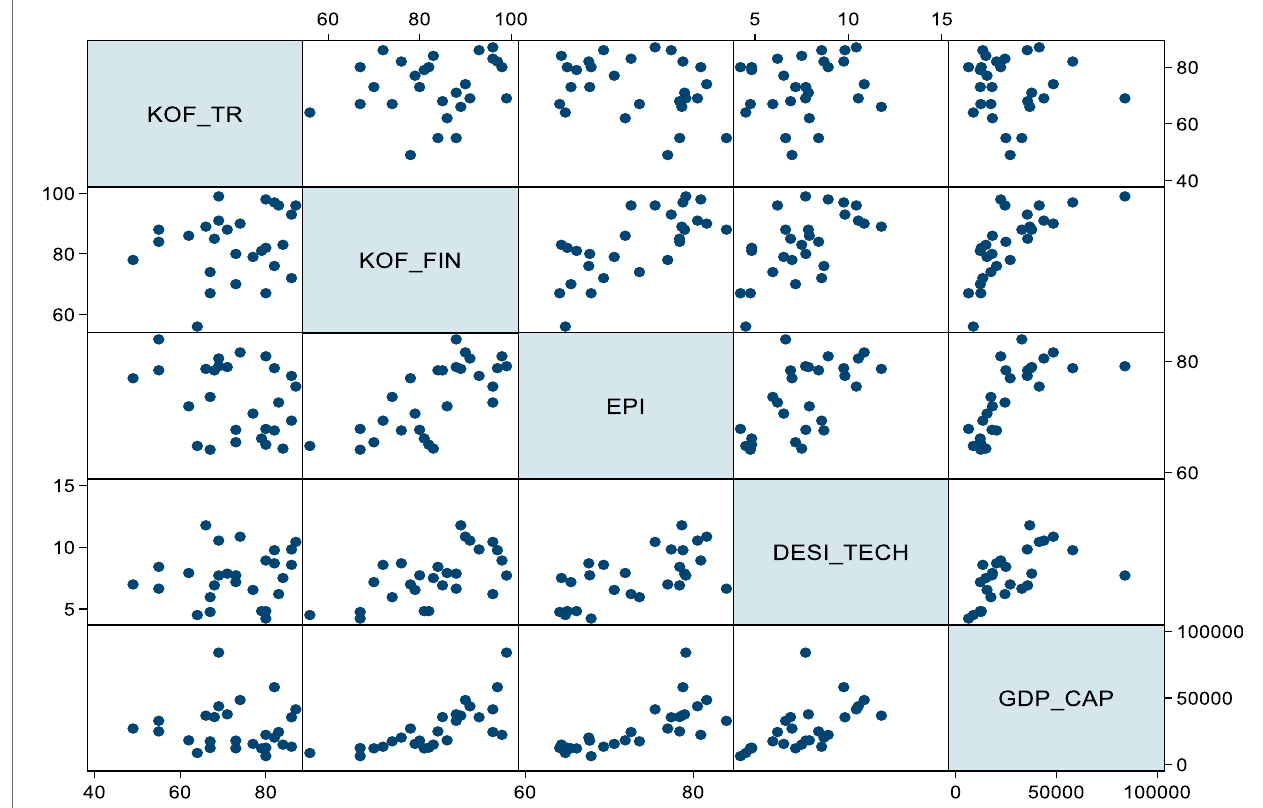
Frontiers in Environmental Science |